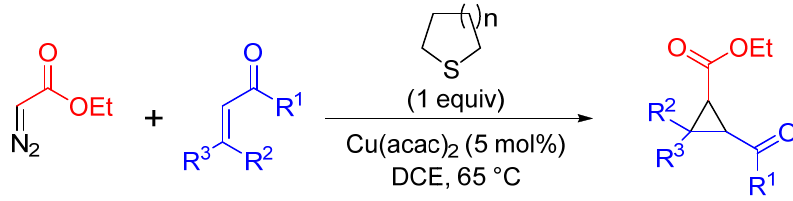
Table 12. Scope of Aggarwal’s sulfide-promoted diastereoselective cyclopropanation (Scheme 36). Entry R 1